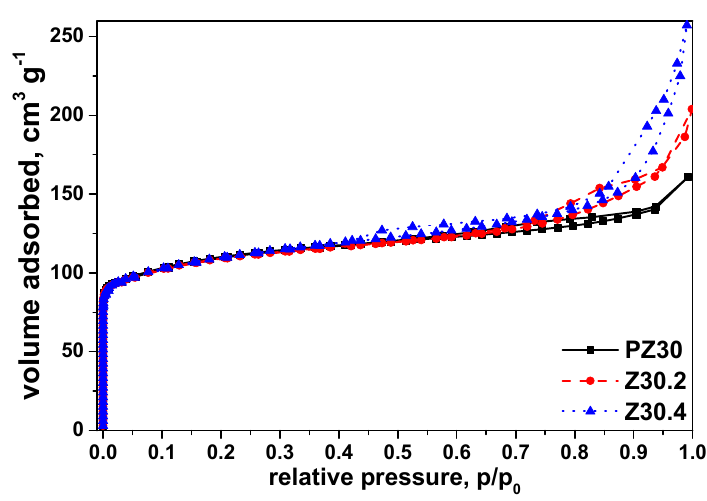
Figure 3. N 2 isotherms of PZ30 (black square, full line), Z30.2 (red circle, dashed line), and Z30.4 (blue triangle, dotted line) at 77 K.